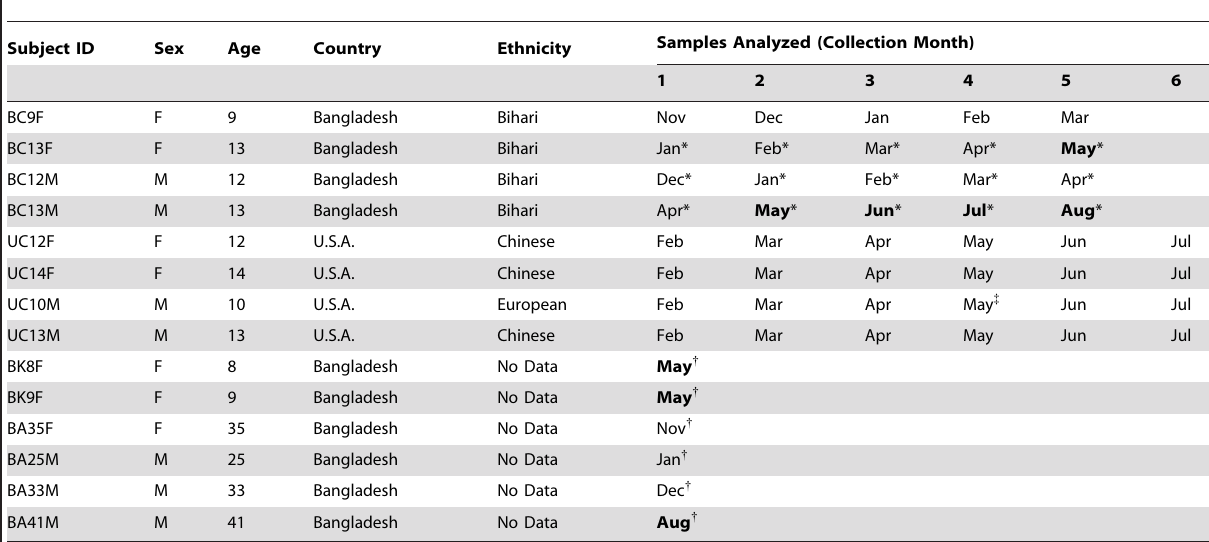
Table 1. Characteristics of the participants in this